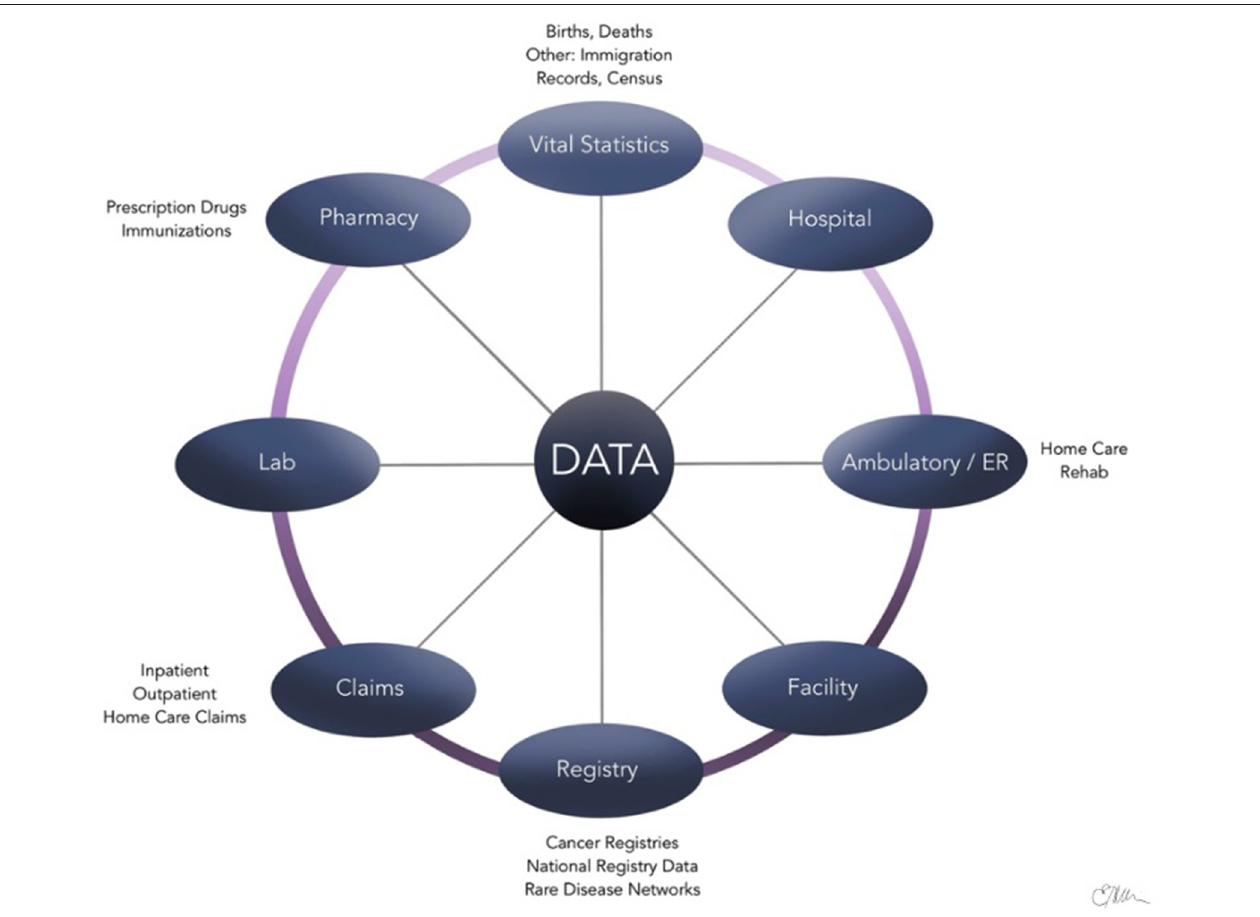
FIGURE 1 | Sources of administrative health